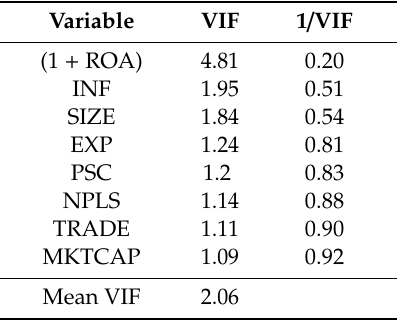
Table A2. Vector inflation factor.